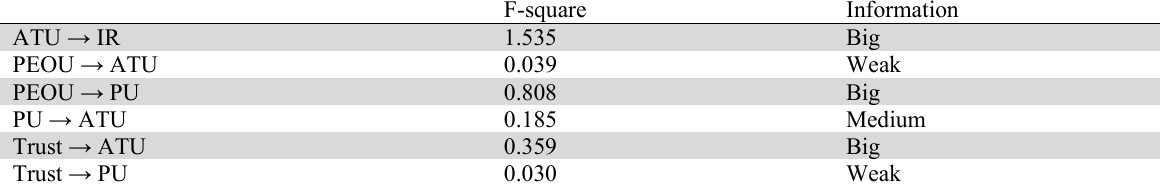
The Relationship Between Exogenous Variables and Endogenous Variables F-square Information ATU → IR 1.535 Big PEOU → ATU 0.039 Weak PEOU → PU 0.808 Big PU → ATU 0.185 Medium Trust → ATU 0.359 Big Trust → PU 0.030 Weak